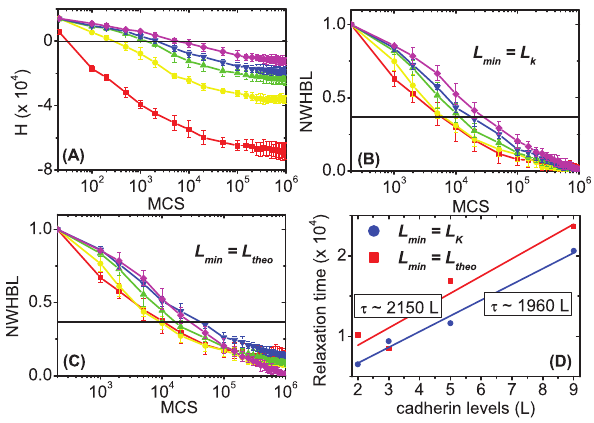
Figure 3. Evolution of the effective energies (H) and normal- ized weighted heterotypic boundary lengths (NWHBL) for aggregates with differing numbers of cadherin levels, with N the same maximum to minimum expression range [1, 23], for – 3 levels; m – 5 levels; . – 9 levels; the THBM. ( A ) – ( C ) & – 2 levels; % – continuous levels. The black horizontal lines mark 1/e. ( A ) Evolution of H . ( B ) – ( C ) Evolution of the NWHBL for the simulations in N ( A ), with L min ~ L k in ( B ) and L min ~ L theo in ( C ). ( D ) Relaxation time vs. : L min ~ L k . The graphs are number of levels. & : L min ~ L theo . calculated from ten simulation